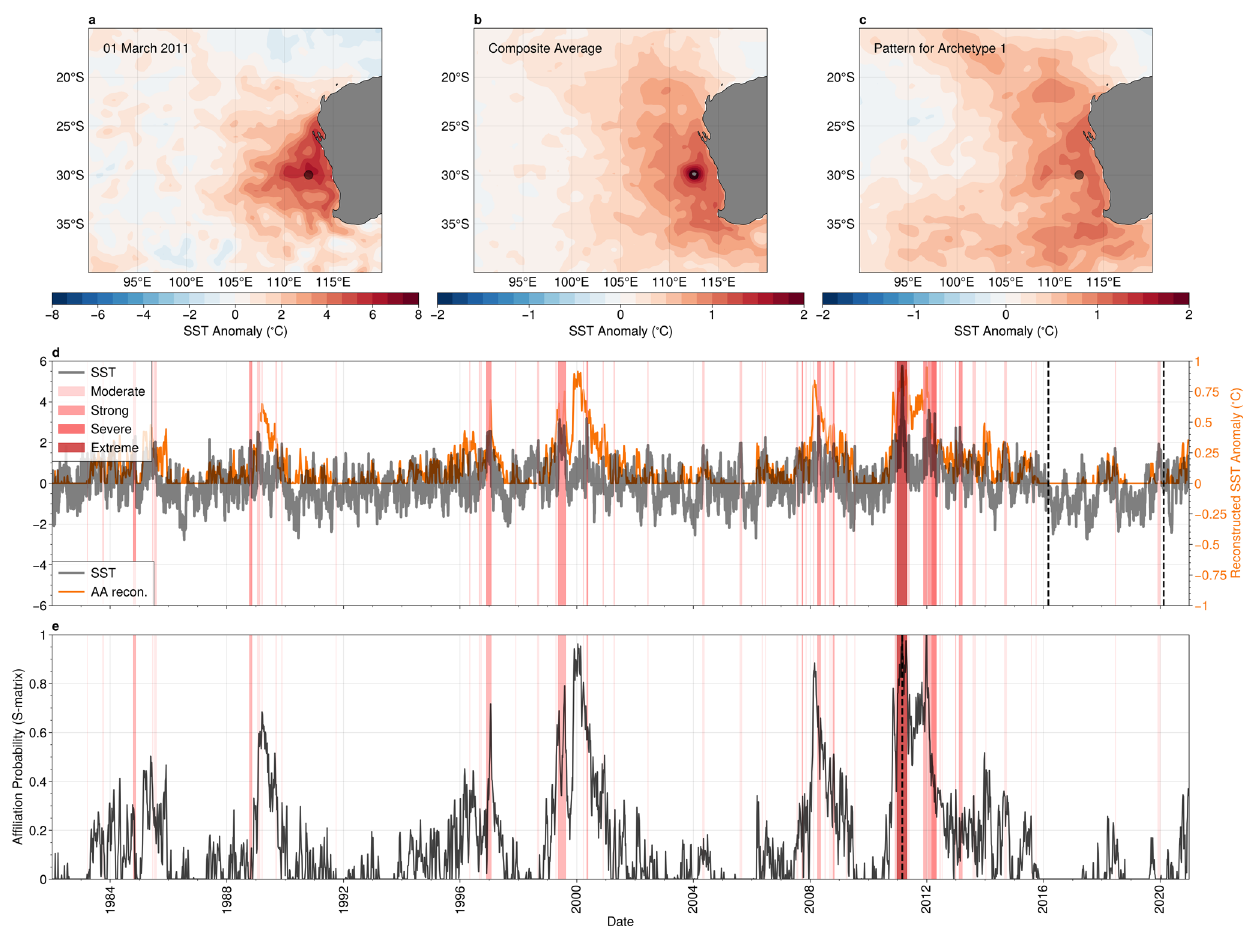
Fig. 3 | The relationship between Marine Heat Waves and Archetype #1 in the Southeastern Indian Ocean. a Snapshot of sea-surface temperature (SST) anomalies for the peak of the 2010 – 2011 extreme marine heatwave event, which occurred on the 1st of March, 2011; and b SST composite average for all marine heatwaves. Statistics are calculated at the representative location 30°S,112.5°E, indicated by the grey circle. c The SST anomalies for best matching archetypal